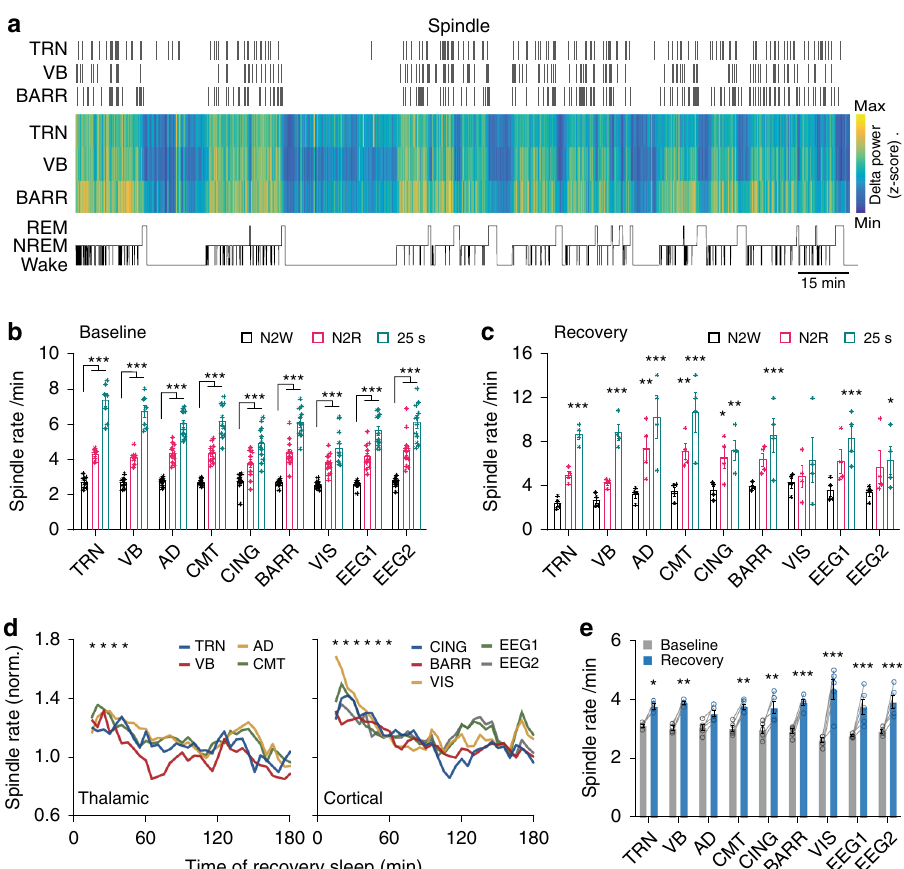
Fig. 4 Spindle rate signi fi cantly increases before REM sleep, but not wakefulness. a Representative spatiotemporal distribution of spindles across the vigilance states. Raster plot illustrates the detected spindles. Color-coded graph shows z -scored delta power across vigilance stats. Hypnogram is depicted below. b Spindle rate during NREM episodes before a transition to wake (N2W) or REM sleep (N2R), and within 25 s before REM sleep onset. Spindle rate of N2R episodes is signi fi cantly higher than of N2W, with a maximum rate within a window of 25 s before REM onset (N2R and 25 s before REM vs. N2W: P < 0.0001 for all sites; F = 891.2; d.f. = 2; two-way ANOVA with Bonferroni ’ s post-hoc test; *** P < 0.001; n = 6 animals for TRN/VB and n = 12 for other sites). c Same as b , but for recovery sleep. Spindle rate signi fi cantly increases before transition to REM sleep (25 s before REM vs. N2W: P < 0.001; F = 70.7; d.f. = 2; two-way ANOVA with Bonferroni ’ s post-hoc test; * P < 0.05, ** P < 0.01, *** P < 0.001; n = 4 animals). d Dynamics of spindle rate during recovery sleep after 4 h of sleep deprivation, estimated using a moving window of 30 min having 25 min overlap. Spindle rate during recovery sleep signi fi cantly increased as compared to baseline, returning to baseline values after 40 min for the thalamic and 60 min for the cortical sites (recovery vs. baseline: thalamic nuclei: P < 0.001; F = 5.9; d.f. = 34; cortical sites: P < 0.001; F = 10.4; d.f. = 34; two-way ANOVA with Bonferroni ’ s post-hoc test; * P < 0.05; n = 4 animals for TRN/VB and n = 5 for other sites). e Spindle rate during baseline and the fi rst 30 min of recovery sleep for the individual sites showed that spindle rate signi fi cantly increased for all sites, except the AD. Cortical recordings showed the highest increase in spindle rate during fi rst 30 min of recovery sleep ( fi rst 30 min of recovery vs. baseline: P < 0.001; F = 190.7; d.f. = 1; two-way ANOVA with Bonferroni ’ s post-hoc test; * P < 0.05, ** P < 0.01, *** P < 0.001; n = 4 animals for TRN/VB, n = 5 for other sites). Bars indicate mean ± SEM. Source data are provided as a Source Data fi